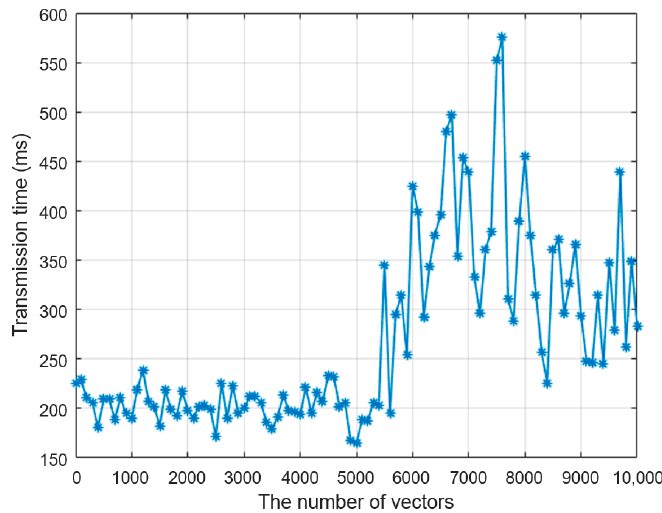
Figure 6. The overall process of the proposed framework.